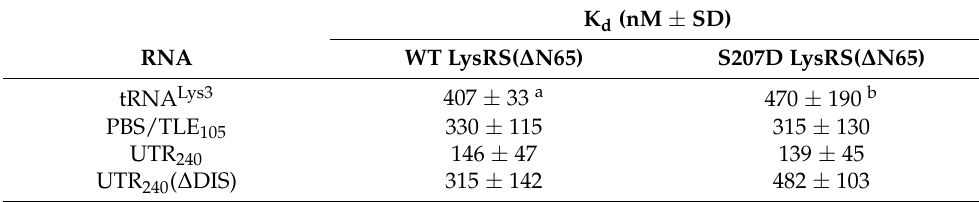
UTR 240 146 ± 47 139 ± 45 UTR 240 ( ∆ DIS) 315 ± 142 482 ± 103 All measurements were performed with 30 nM RNA in 15 mM NaCl, 35 mM KCl, 20 mM Tris–HCl pH 8, and 1 mM MgCl